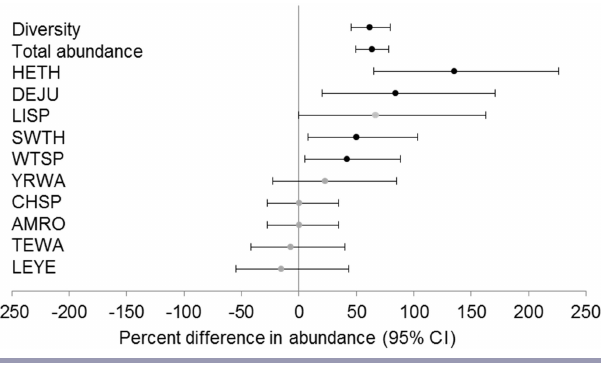
Fig. 4 . Percent difference (95% confidence interval [CI]) in relative abundance in counts from human North American Breeding Bird Survey and forest-edge autonomous recording unit maximum count surveys. Black circles indicate statistically significant differences. See Figure 2 legend for details. See Results for definitions of abbreviations.